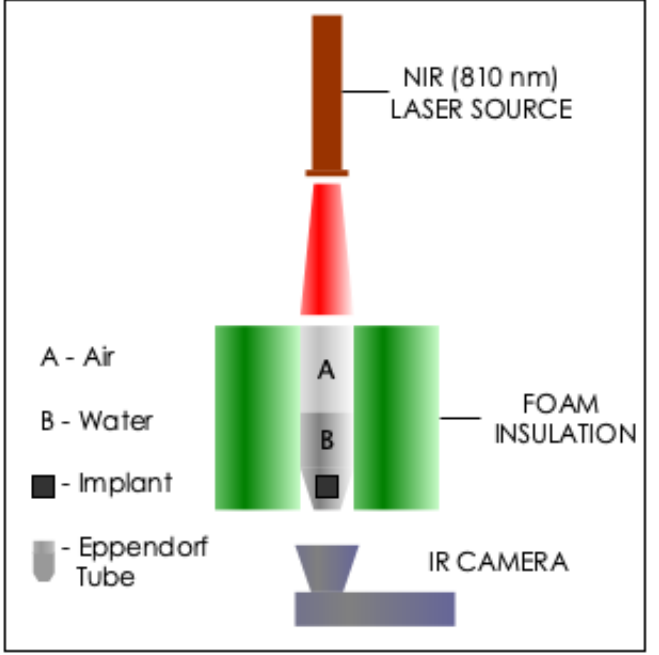
Figure 1. Experimental setup used for the photothermal measurments. The sample (a photoseed and 0.5 mL of deionized water or suspension of cells) contained in a 1.5 mL Eppendorf tube was irradiated by a near-infrared continuous laser at a wavelength of 810